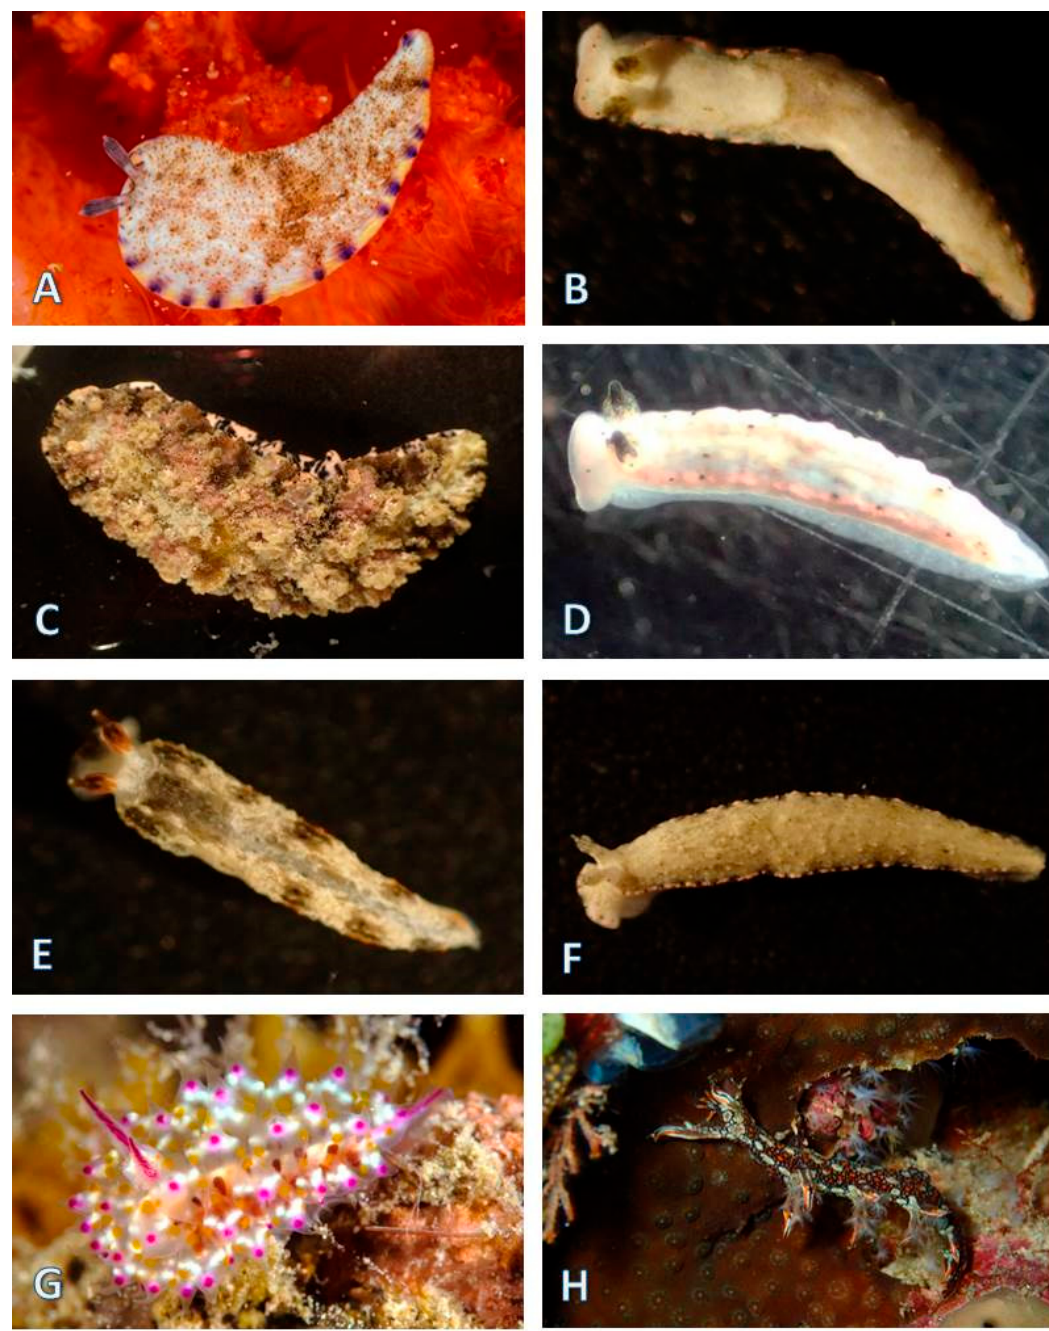
Figure 19. Nudibranchia Cladobranchia: ( A ) Dermatobranchus caeruleomaculatus *; ( B ) Dermatobranchus rodmani , Dero18Ba-1; ( C ) Dermatobranchus pustulosus , Depu18Ba-1; ( D ) Dermatobranchus sp. a, Desp.a18Ba-1; ( E ) Dermatobranchus sp. b, Desp18Ba-1; ( F ) Dermatobranchus sp. c, Desp17Ba-1; ( G ) Janolus sp. ( Janolus sp. 1 in Gosliner et al. [24]: 305)*; ( H ) Bornella anguilla , Boan17Ba-1. *Specimen not collected.